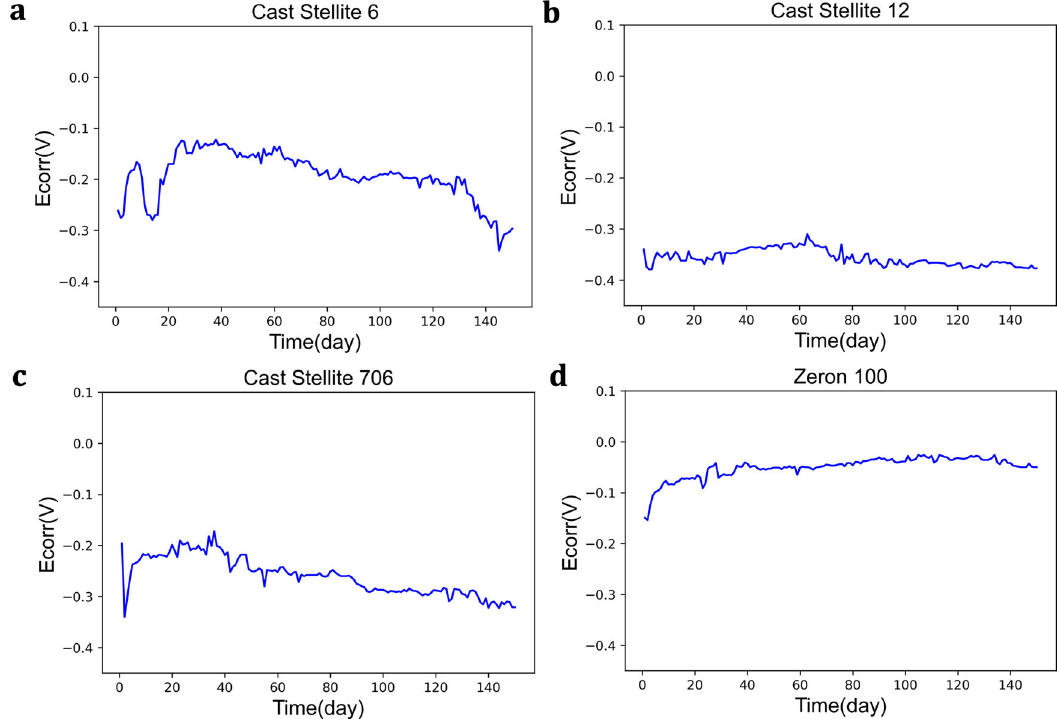
Fig. 2 The visualization of original dataset for different alloys. The free corrosion potential (E corr ) values measured during the immersion period of 150 days: a Cast Stellite 6, b Cast Stellite 12, c Cast Stellite 706, and d Zeron 100.